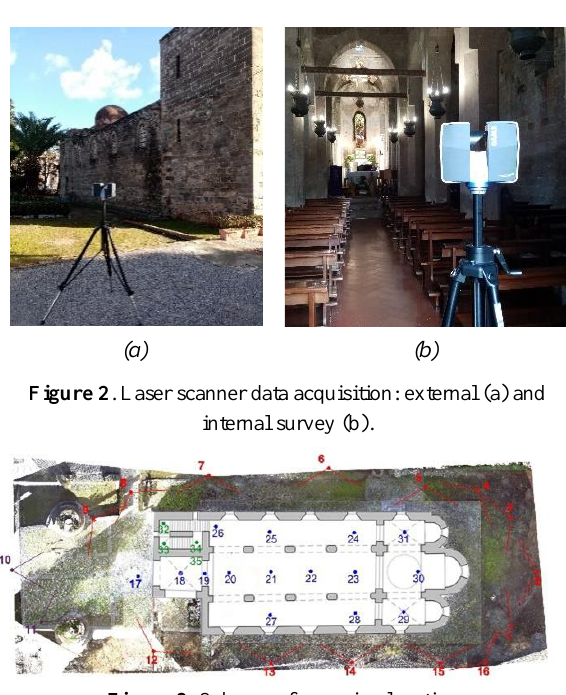
Figure 3 . Scheme of scanning